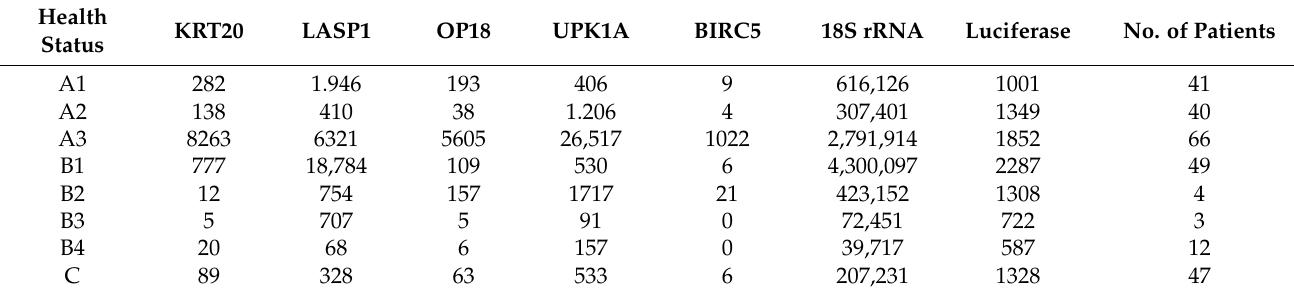
Abbreviations: A1, low-risk; A2, intermediate-risk; A3, high-risk; B1, urinary tract infection; B2, urolithiasis, B3, relevant malignant co-disease (e.g., prostate carcinoma), B4, relevant benign co-disease (e.g., papilloma/papillary neoplasia, benign prostatic hyperplasia, prostate